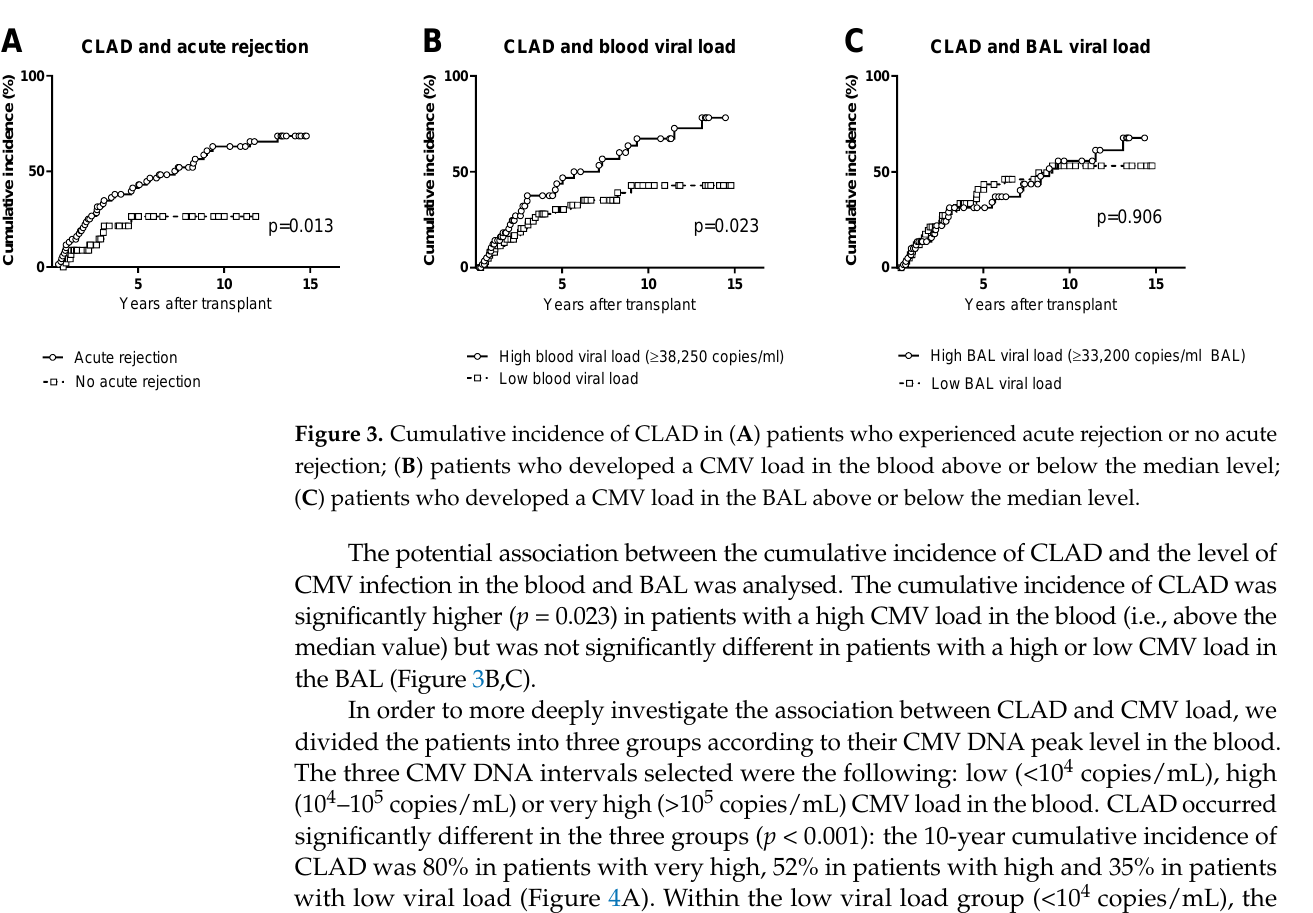
Figure 4. Cumulative incidence of ( A ) CLAD; ( B ) BOS; ( C ) RAS in patients who developed three progressively higher levels of CMV load in the blood. When we analysed the occurrence of BOS and RAS separately (Figure 4B,C), we found that BOS was significantly more common ( p = 0.024) in patients with a very high viral load (10-year cumulative incidence: 70%) compared to patients with a high or low viral load, in whom the cumulative incidence of BOS was similar (35% and 30%, respec- tively). On the contrary, RAS occurrence was more common (and at a similar rate) in pa- tients with a very high and high viral load (10-year cumulative incidence: 33% and 23%, respectively) compared to patients with a low viral load (6%, p < 0.001). We then analysed the potential association between CMV infection, acute rejection or CLAD with the following factors: sex, age (below or above the median value of 54